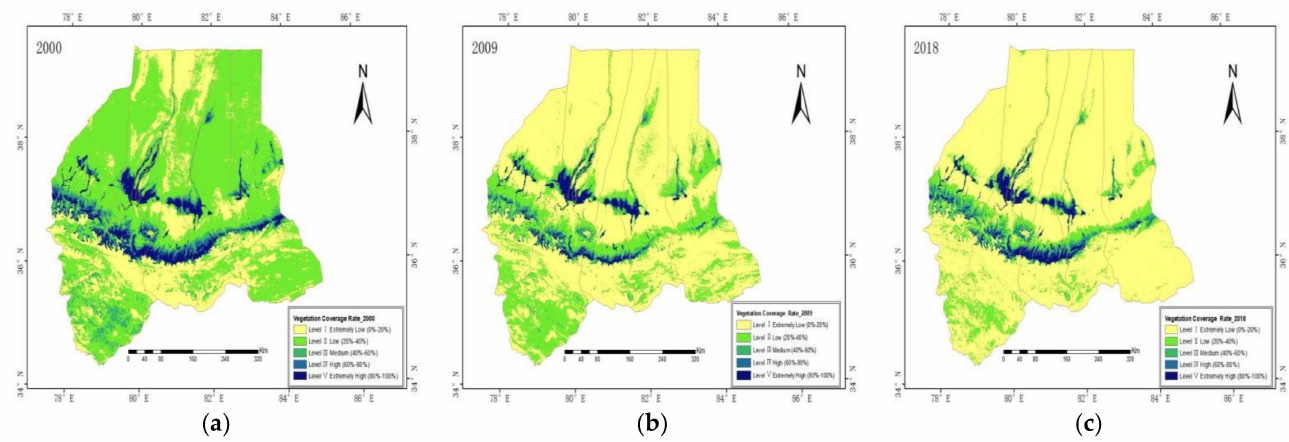
Figure 3. Results of vegetation coverage classification in Hetian: ( a ) 1995; ( b ) 2009; ( c ) 2018.